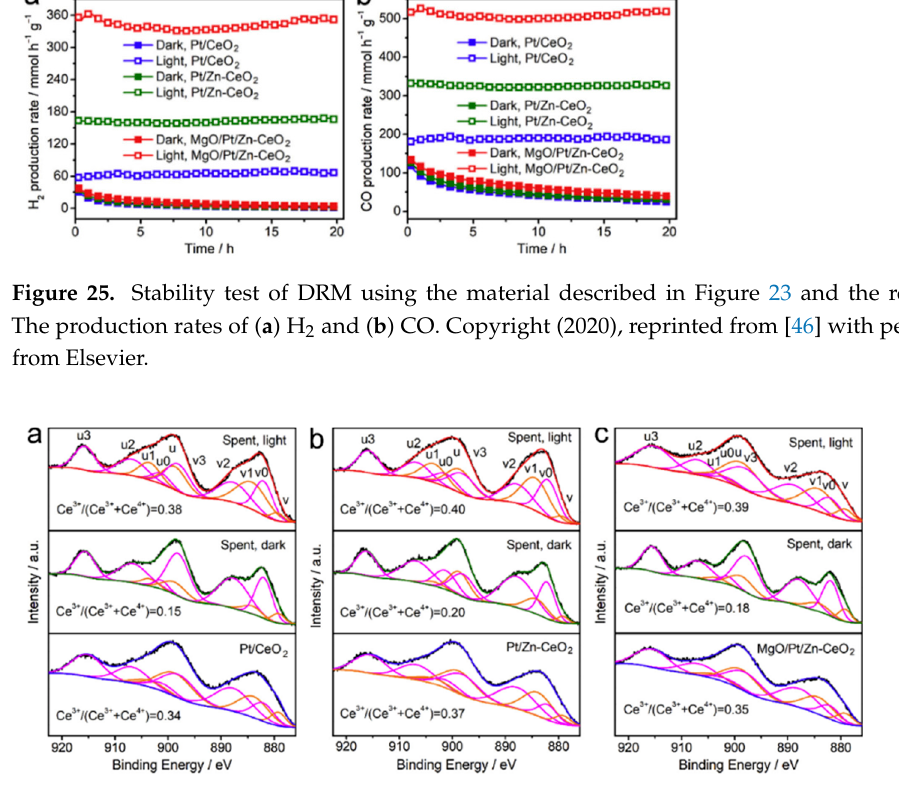
Figure 26. XPS profiles of ( a ) Pt/CeO 2 , ( b ) Pt/Zn-CeO 2 , and ( c ) MgO/Pt/Zn-CeO 2 . Each sample has spent data under dark light conditions and as a prepared sample. The ratio of Ce 3+ /(Ce 3+ + Ce 4+ ) was calculated from the data. Copyright (2020), reprinted from [46] with permission from Elsevier.